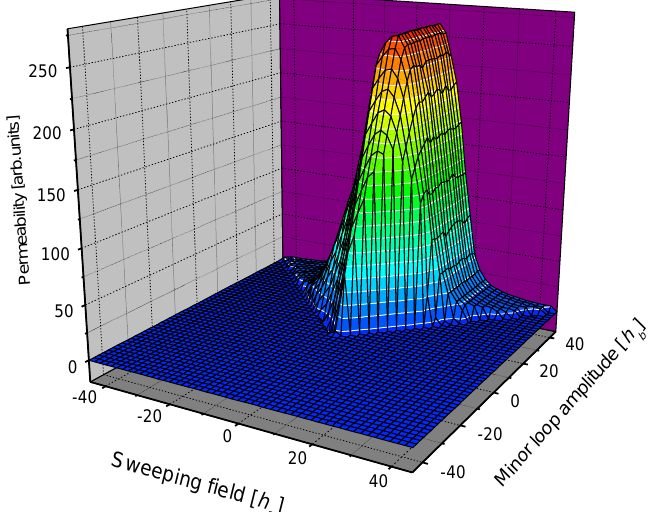
Figure 5. A 3D representation of the m permeability matrix.